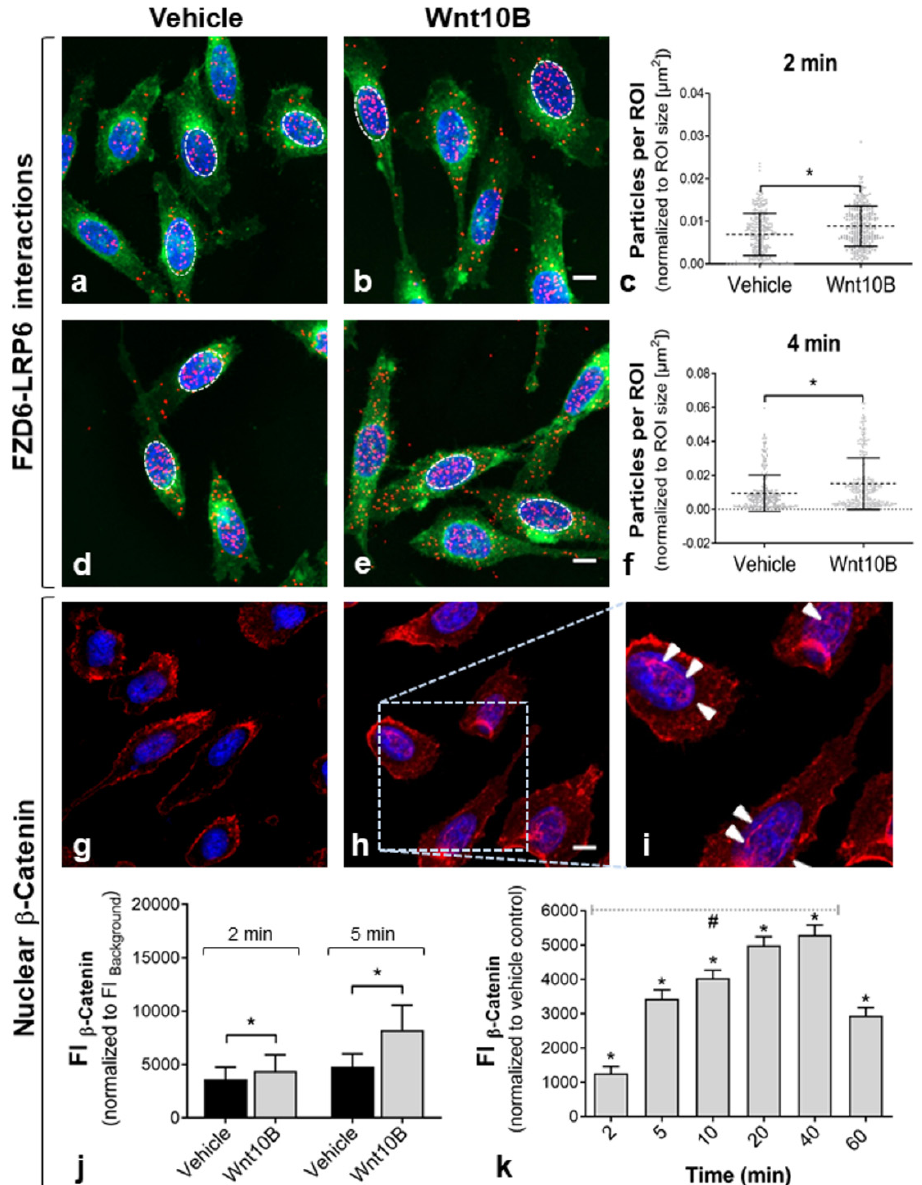
Figure 3. Wnt10B-dependent activation of the canonical Wnt/ β -catenin pathway following FZD6–LRP6 co-localization. Co-localization of FZD6 and LRP6 by Wnt10B treatment and subsequent detection of nuclear β -catenin indicates rapid receptor interaction and early Wnt/ β -catenin signaling in PC-3. ( a – f ) Detection of FZD6–LRP6 interaction complexes by PLA after 2 and 4 min of Wnt10B incubation ( b , e ) versus vehicle-treated controls ( a , d ). FZD6–LRP6 interaction complexes were frequently observed in the nuclei (circles). FZD6–LRP6 complexes (red); plasma membranes (green); nuclei (blue). Scale bar: 10 µ m. ( c , f ) Quantification of PLA signal density by particle analyses at the single-cell level. Particles were normalized to the area of cells (ROIs). The amount of FZD6–LRP6 complexes was significantly higher after both 2 min ( n = 317 vs. n , =; 297; cells, ) and 4 min ( n = 264 vs. n = 263 cells, vehicle vs. Wnt10B) of Wnt10B incubation (* p ≤ 0.05, Mann–Whitney Test); mean + SD; n = 3 independent experiments. ( g – k ) Well-documented translocation of β -catenin into the nucleus. ( g – i ) Immunofluorescence images of β -catenin staining. ( g ) Membrane association of β -catenin in control